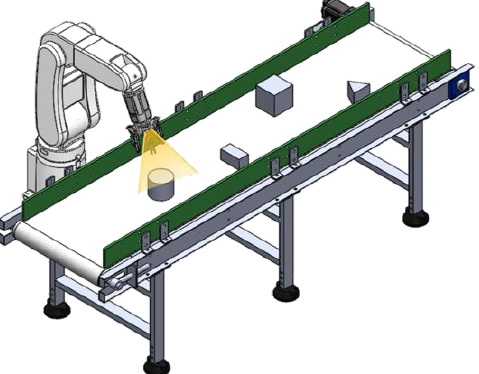
Figure 18. Visual adaption platform for the model eye-in-hand robotic gripper mimicking pick-and- place application in the manufacturing process.